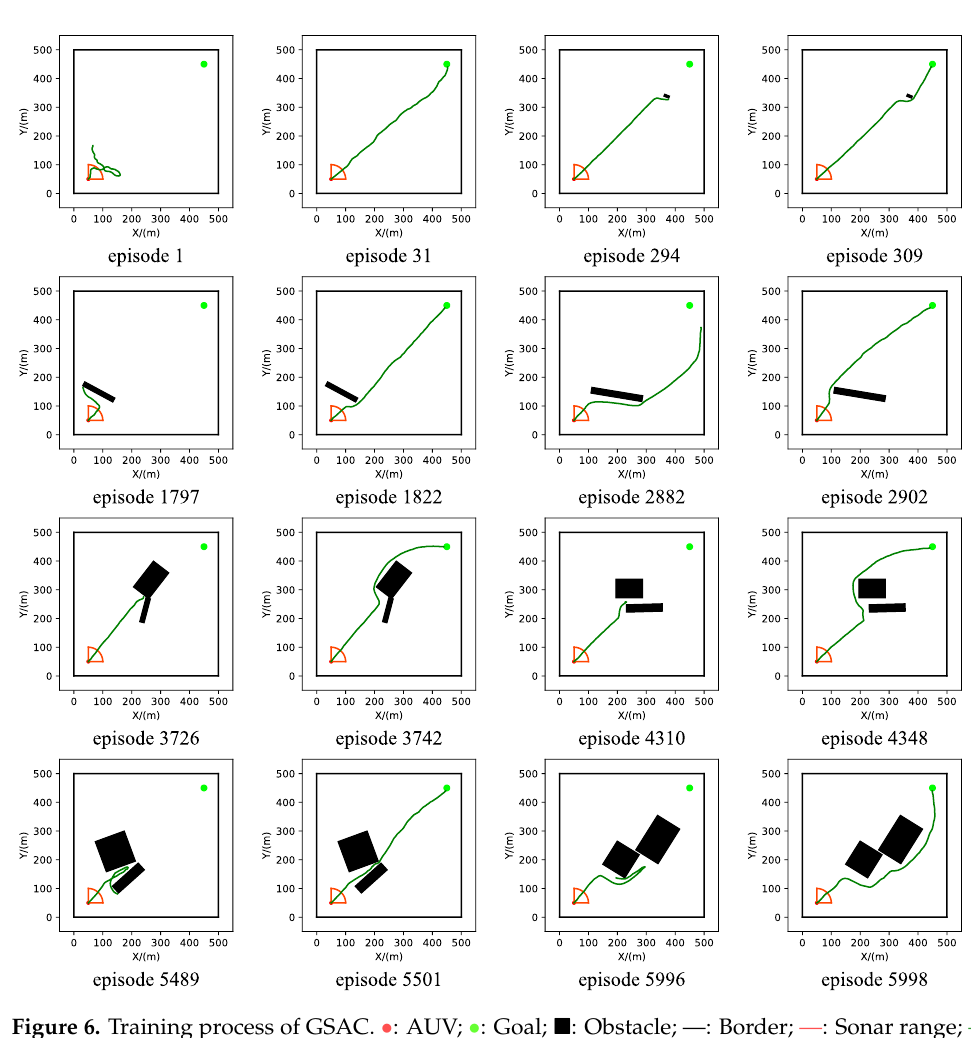
Figure 6. Training process of GSAC. • : AUV; • : Goal; (cid:4) : Obstacle; —: Border; —: Sonar range; —: AUV trajectory.